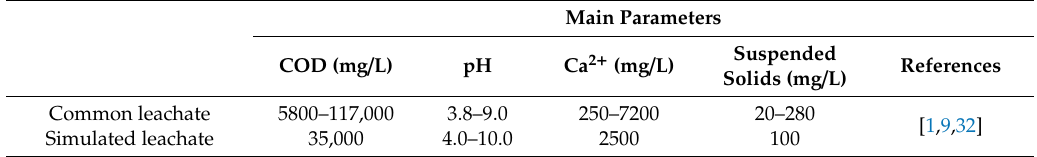
Table 3. Water quality parameters for the simulated